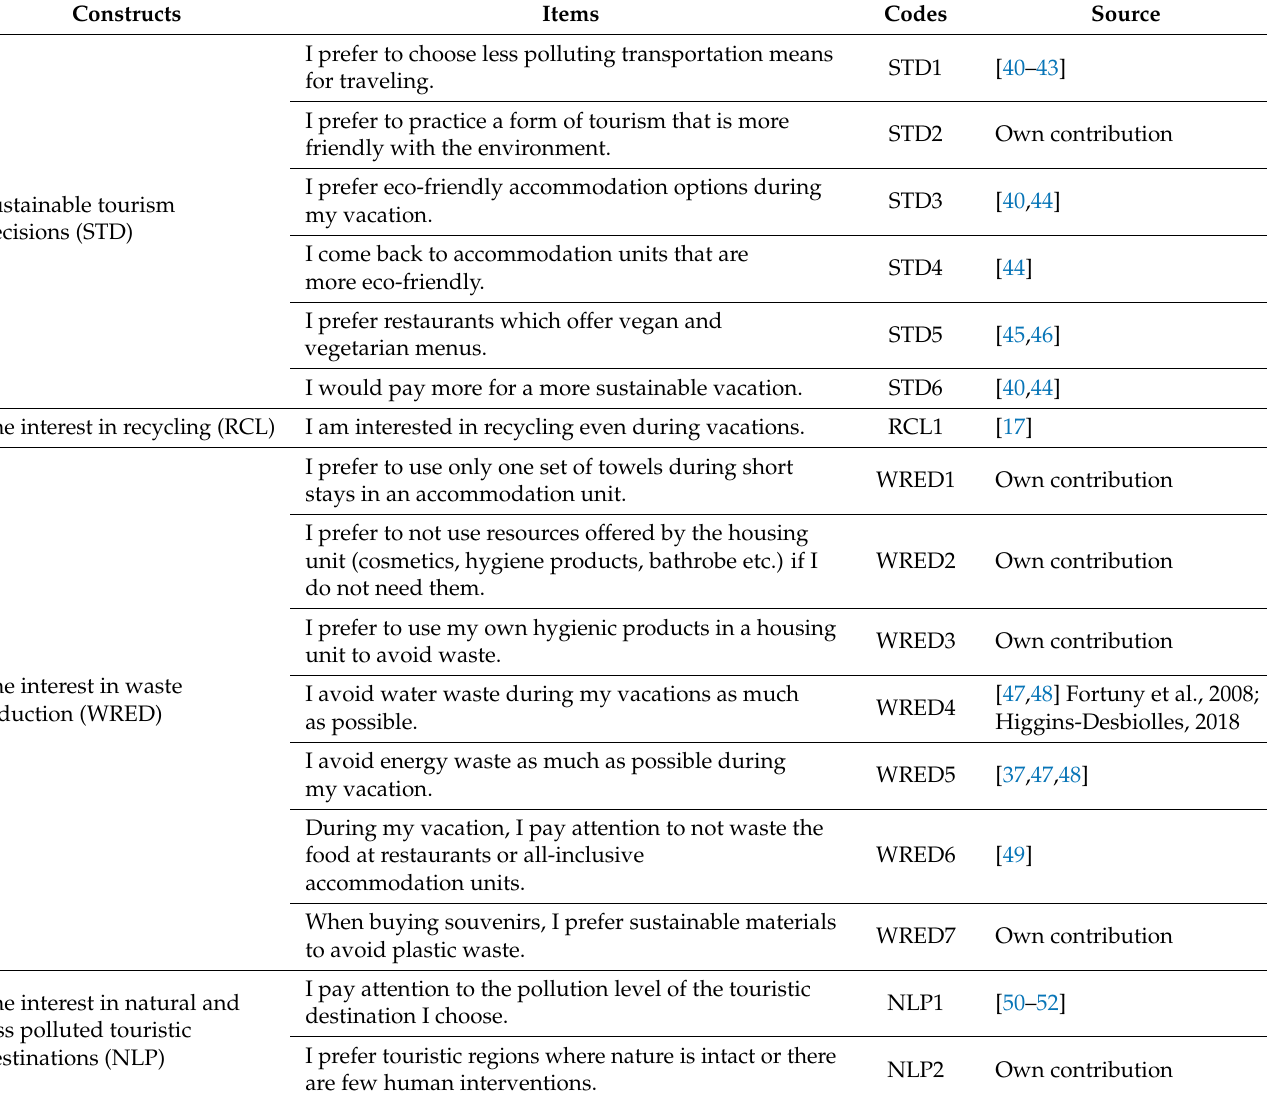
Table 1. Constructs and items in the